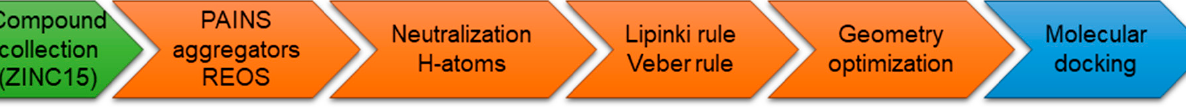
Figure 3. Library preparation for molecular docking calculations on the b1 domain of NRP1. The final library contained 956,355 molecules. Table 1. Inhibition of the spike S1 binding to NRP1 by the compounds selected using molecular docking calculations.